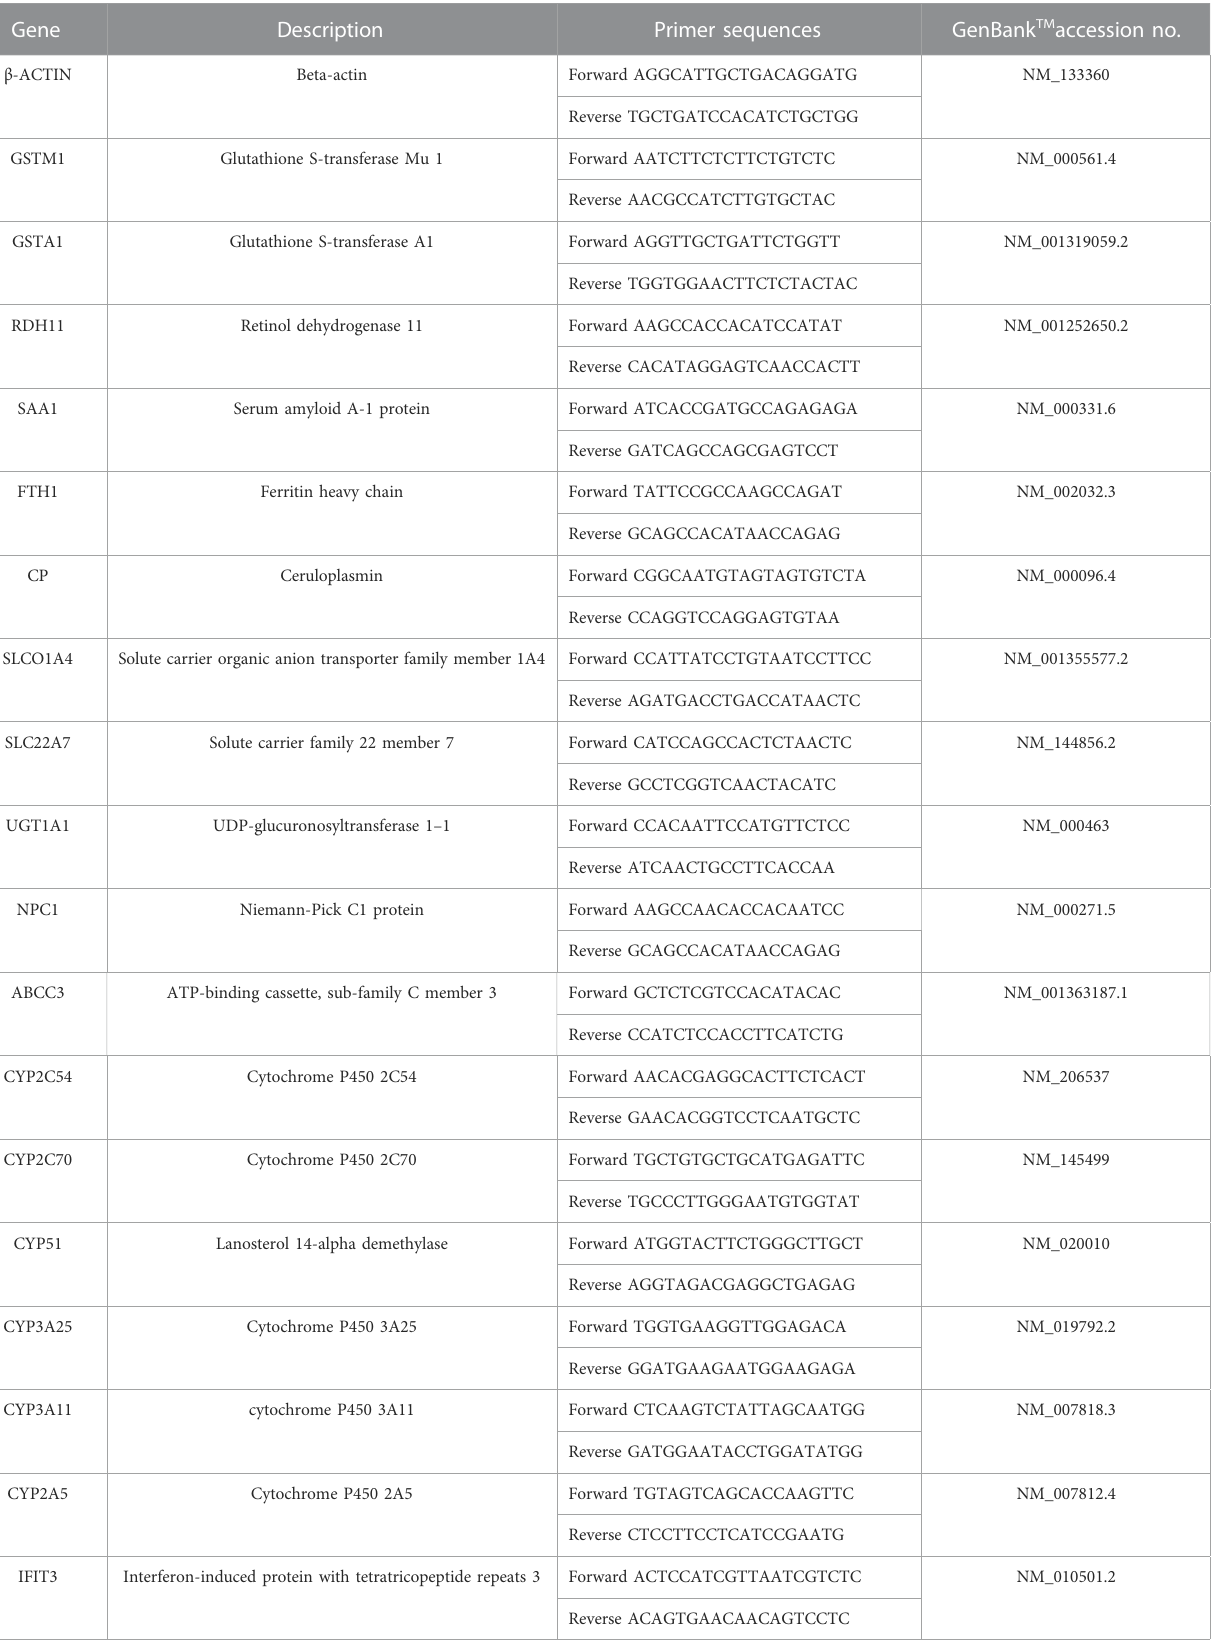
TABLE 1 Polymerase chain reaction primers used in the